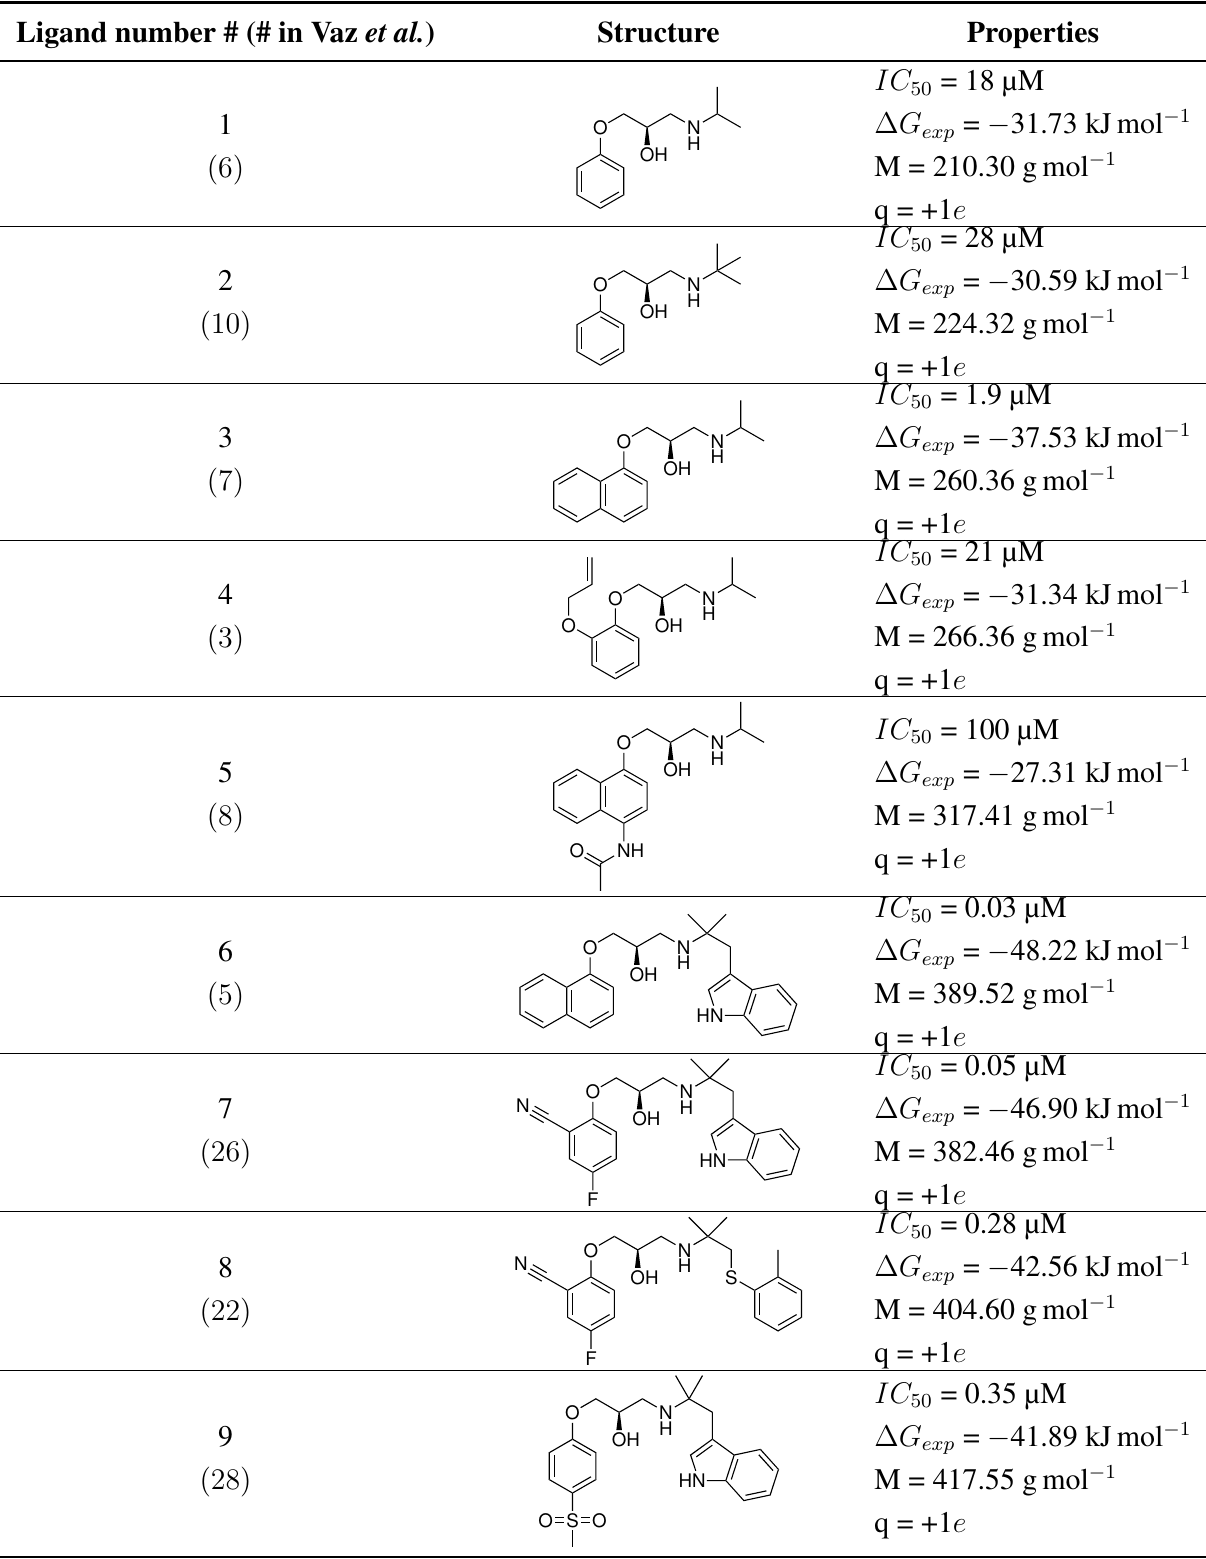
Table 1. Compounds used in training of the CYP 2D6 LIE model for aryloxypropanolamines. Experimental values for IC ’s (reported by Vaz et al. [27]) and 50 derived binding free energies ( ∆ G ) are given, as well as Molar masses (M) and net charges exp of the compounds